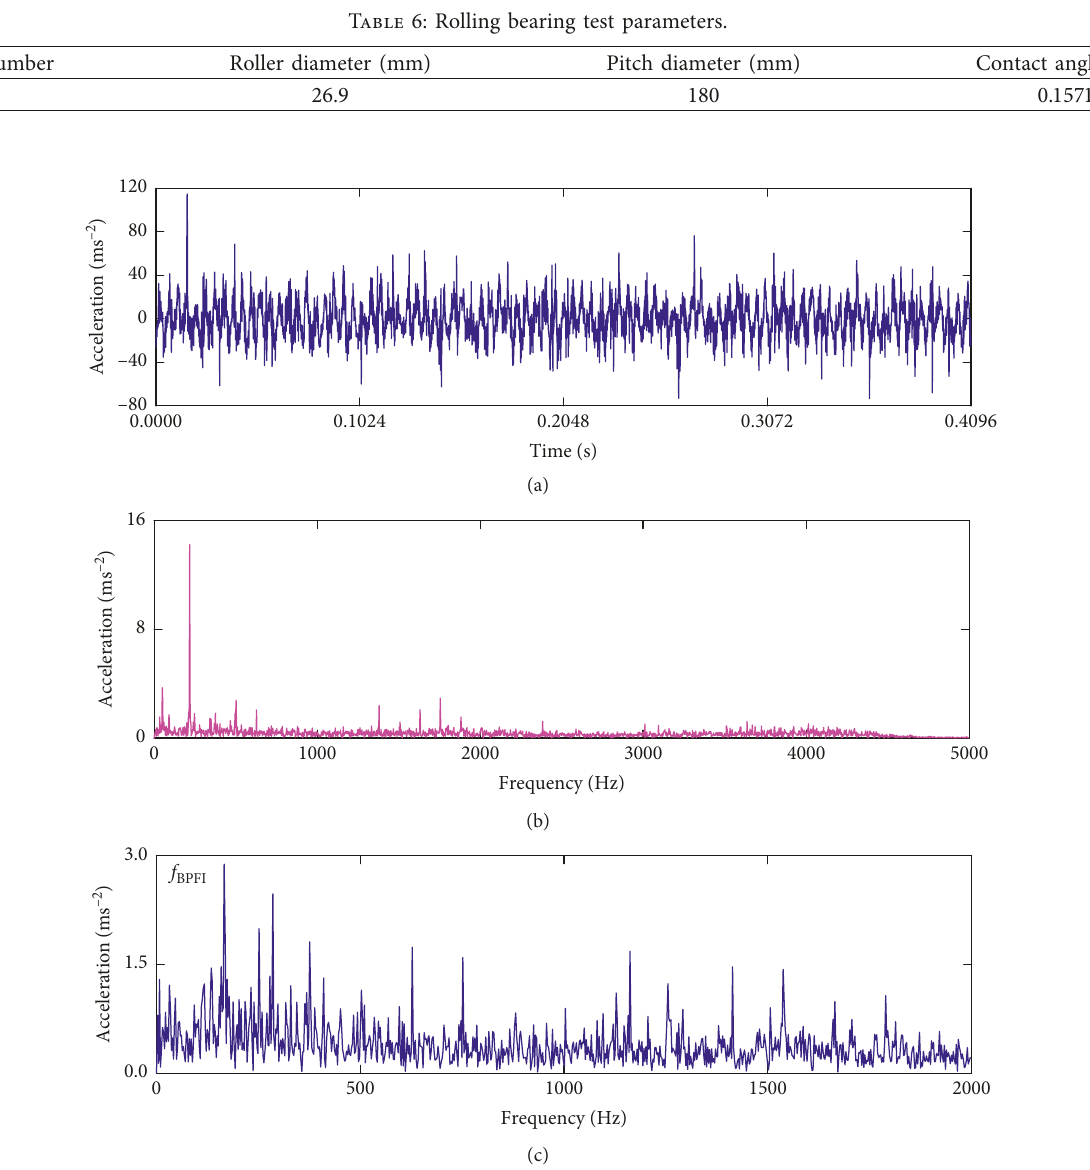
Figure 24: Measured signals: (a) time-domain waveform; (b) Fourier spectra of (a); (c) envelope spectra of